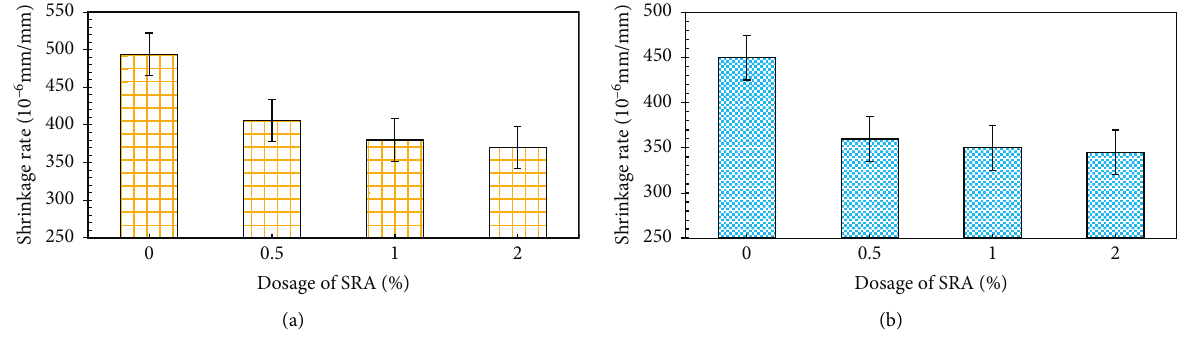
Figure 15: Shrinkage of the concrete with (a) drying and (b) CGC prewetting (24 h) at